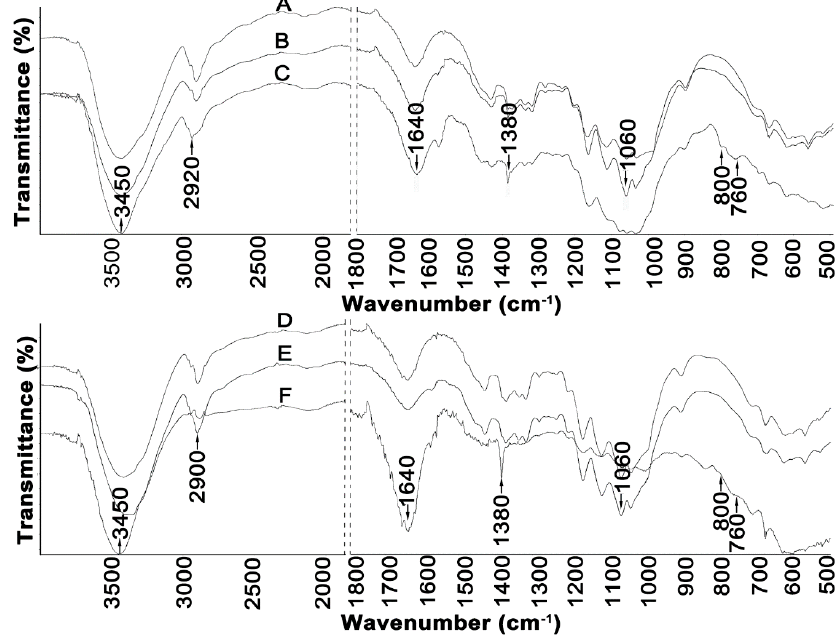
Figure 3. FTIR spectra of: ( A ) Avicel, ( B ) Avicel treated with [EMIM][Cl], ( C ) Avicel treated with [PMIM][Cl], ( D ) Sigmacell, ( E ) Sigmacell treated with [EMIM][Cl], and ( F ) Sigmacell treated with